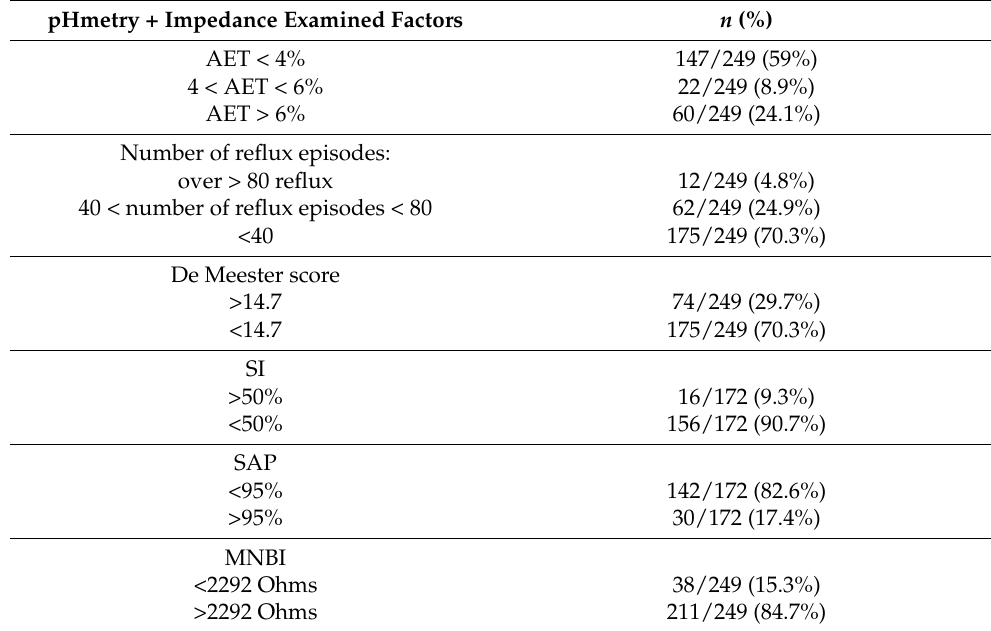
Table 2. PHmetry + impedance findings.